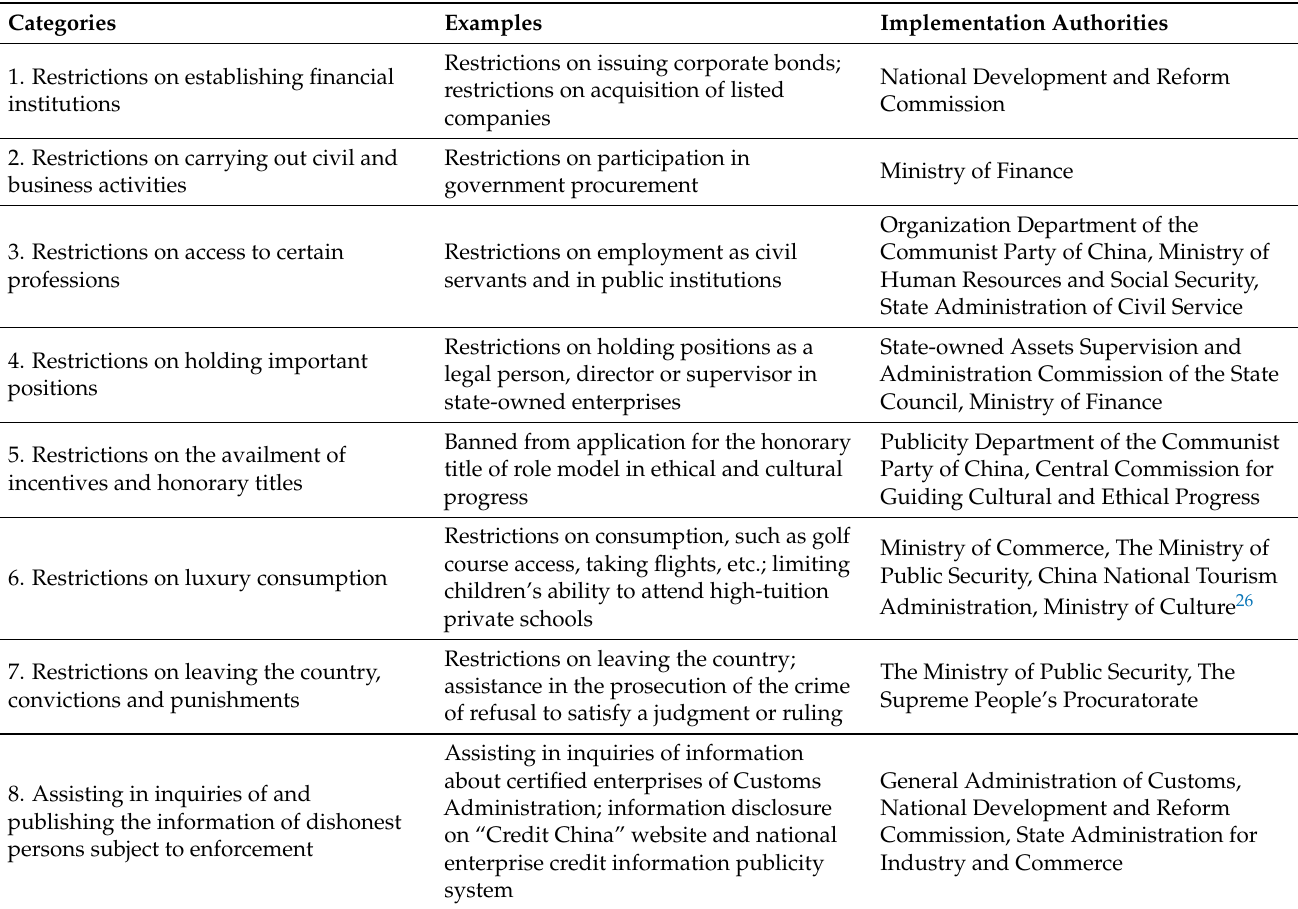
Table A1. Punishment measures from Cooperation Memorandum of Understanding on Taking Joint